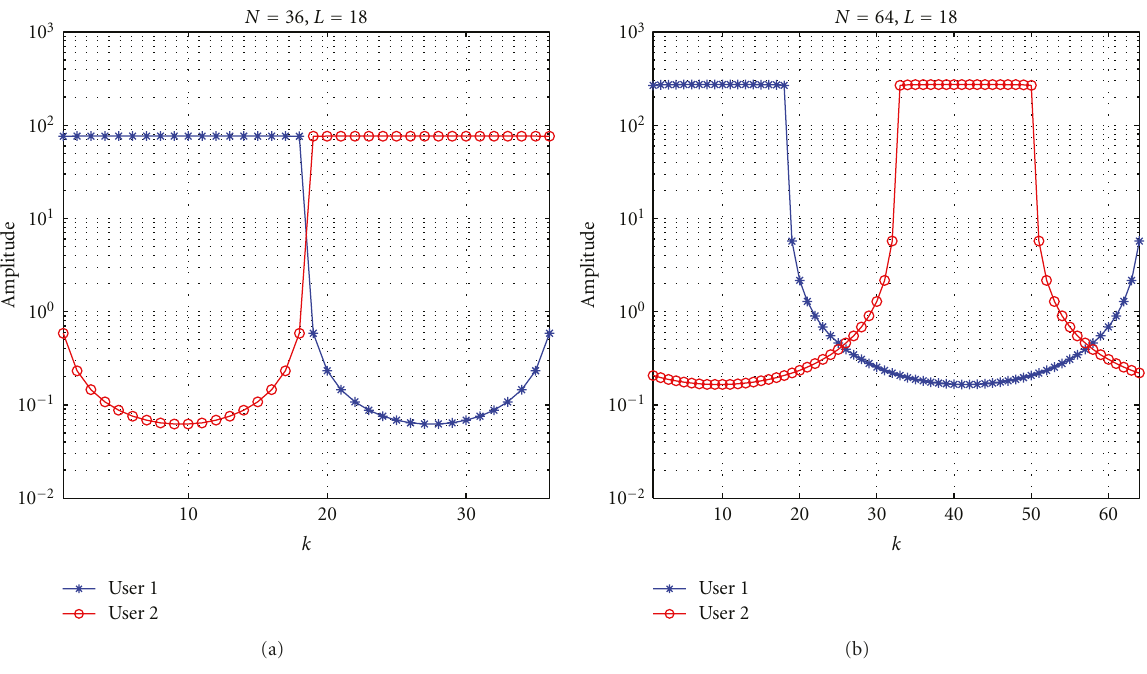
Figure 7: Comparison of useful signal and interference power for di ff erent sequence lengths (uniform power delay profile).